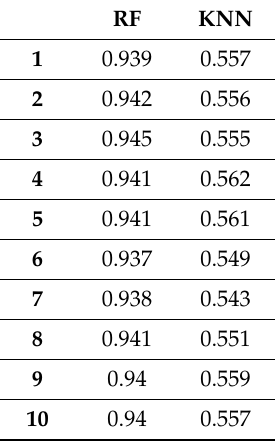
Table 10. F-measure value for KNN and RF with raw data. Trained and tested against raw data.